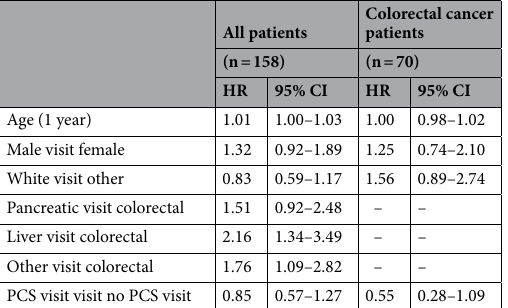
Table 4. Multivariable model of survival among patients referred to palliative care services and survived at least 30 days after referral, at a single institution, 2014–2018. PCS Palliative care services, HR Hazard ratio, CI Confidence